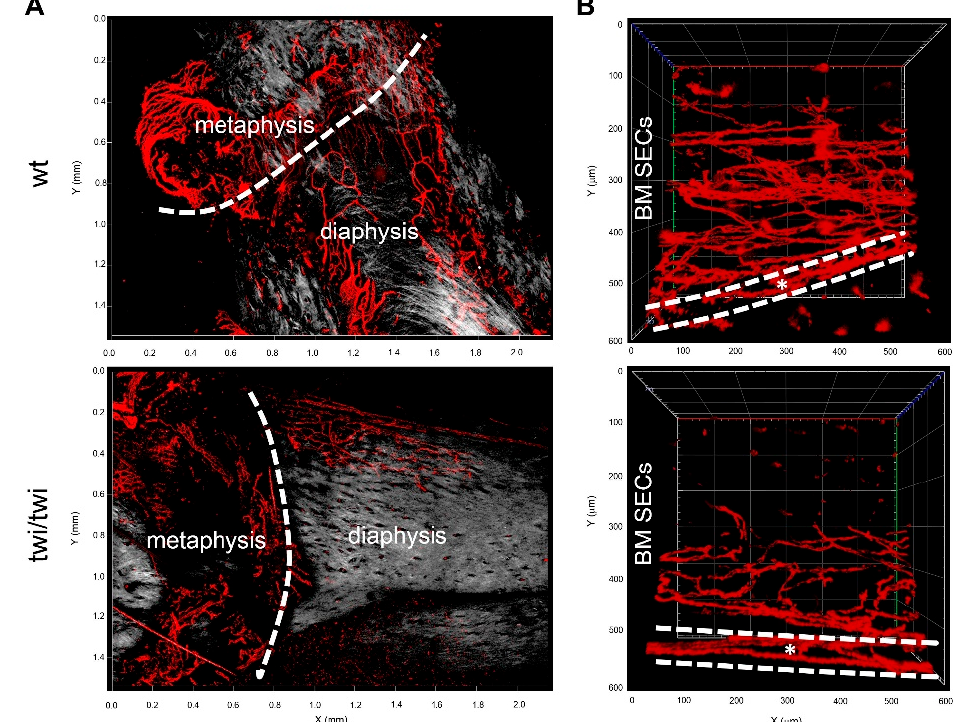
Figure 3. Two-photon microscopy analysis of CD31 expression in diaphyseal, metaphyseal and cortical bone vessels of twitcher mice. ( A ) 3D reconstruction of CD31 + vessels (in red) and stromal collagen expression revealed by second harmonic generation (in grey) in diaphysis and metaphysis of wt and twitcher mice (Z = 422 μ m and 588 μ m for wt and twi/twi specimens, respectively). ( B ) Cross-sectional view of CD31 + vessels in diaphysis and cortical bone (dashed white lines) of wt and twitcher mice (Z = 294 μ m and 352 μ m, respectively).